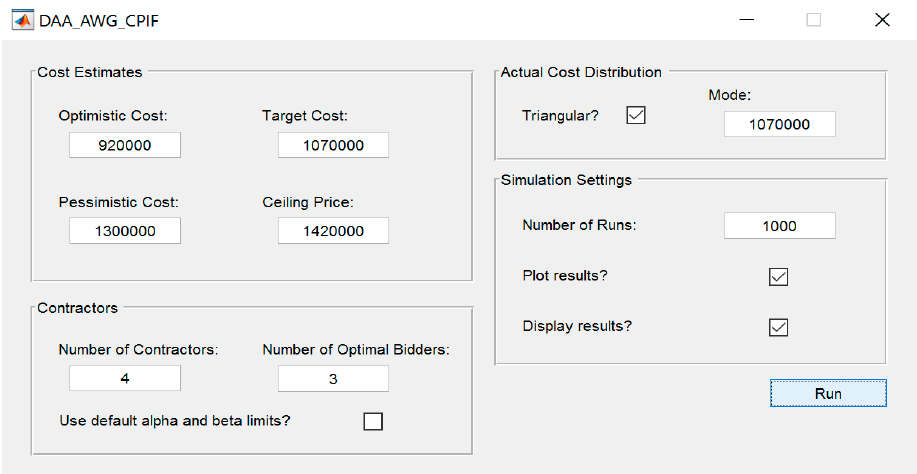
Figure 11. DAA-AWGE CPIF Input.